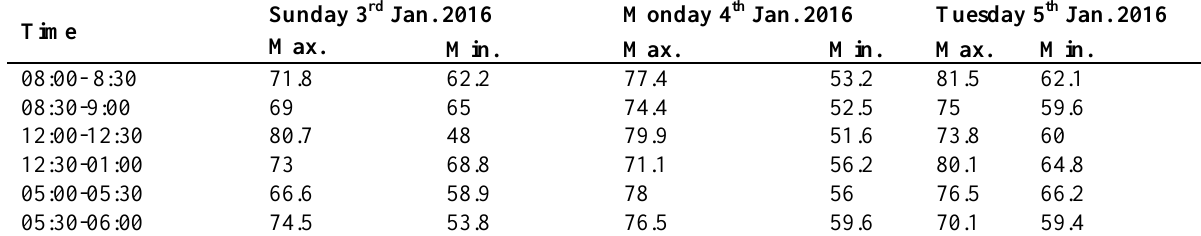
Table 9, Noise levels at AL Nasir region.